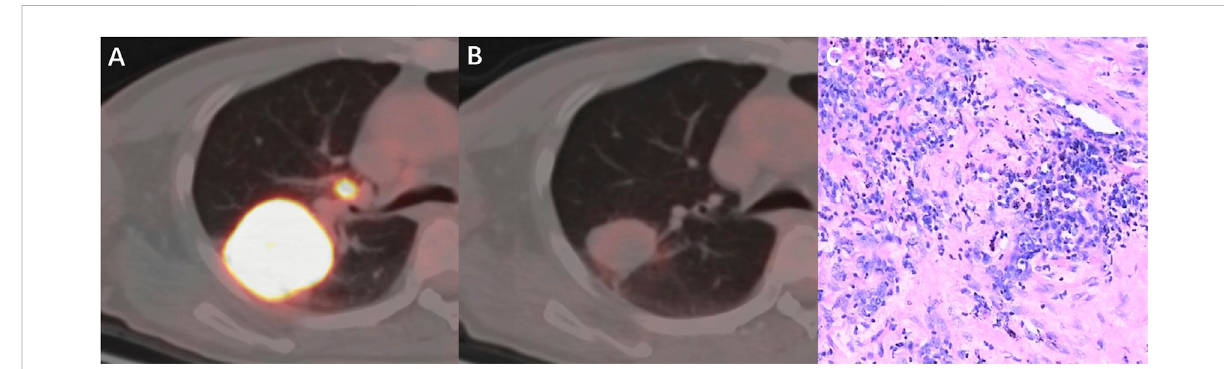
FIGURE 4 A 53-year-old man with squamous cell carcinoma, who had marked metabolic changes on PET scanning after two cycles of neoadjuvant immunochemotherapyandwasclassi fi edasresponderperiPERCIST-max. (A) BaselinePET-CTfusionimageoftheprimarytumorandlymphnodes; (B) Follow-up PET-CT fusion image showed markedly reduced metabolic activity of the tumor. (C) pathological examination revealed this patient had mPR disease. mPR, major pathological